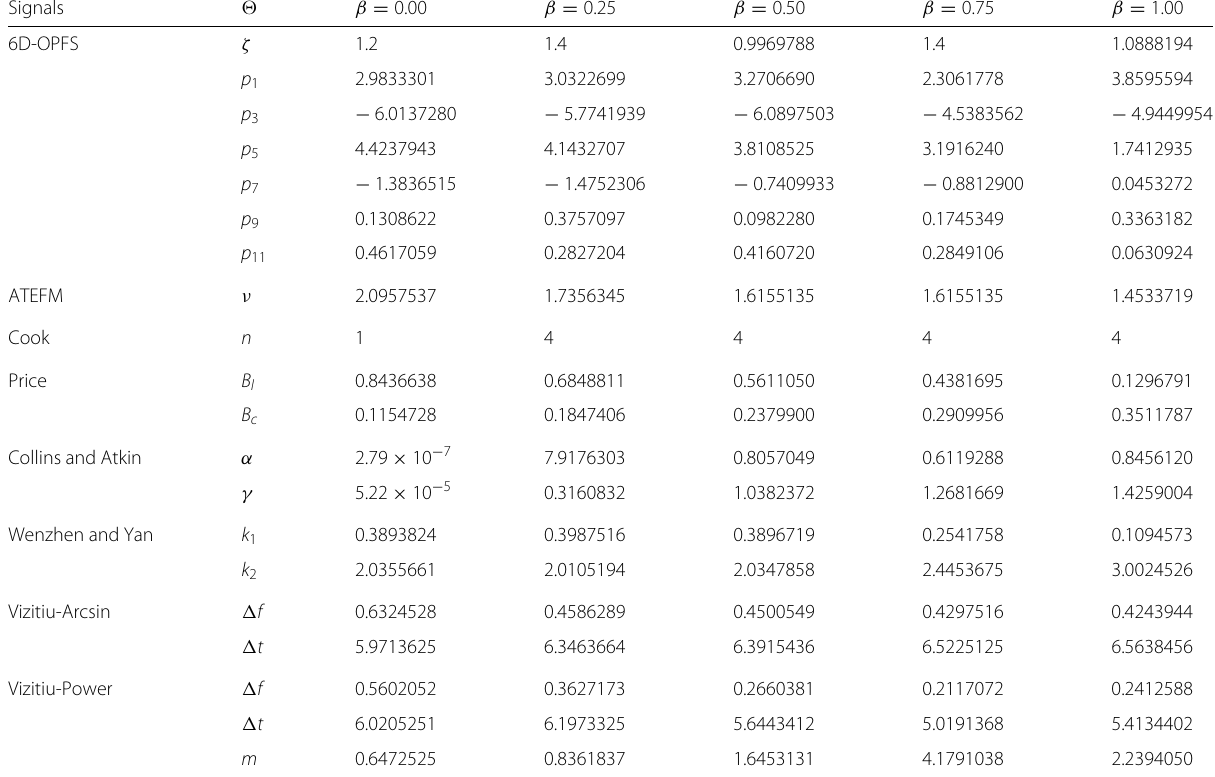
Table 1 Table listing signal parameters obtained from optimization routines for B = 1000, T = 0.1, and M = 1001